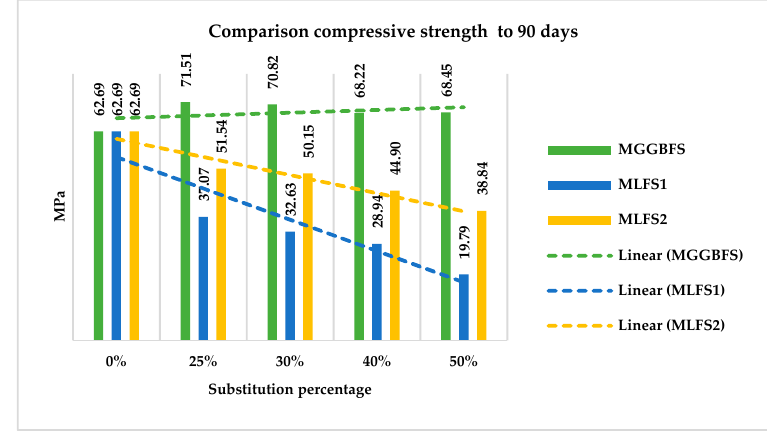
Figure 9. Comparison compressive strength to 90 days, for the three different slag.